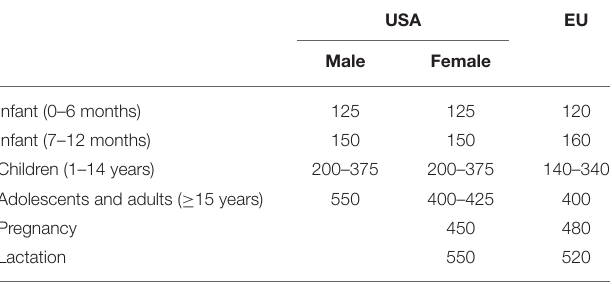
TABLE 1 | Adequate choline intake (mg/d) in USA and